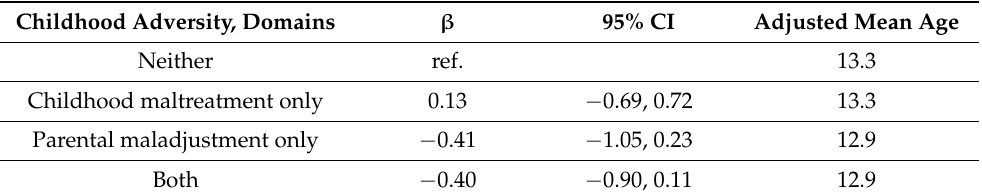
Table A2. Multivariable associations between childhood adversity domains and mean age at menar- che, (N =